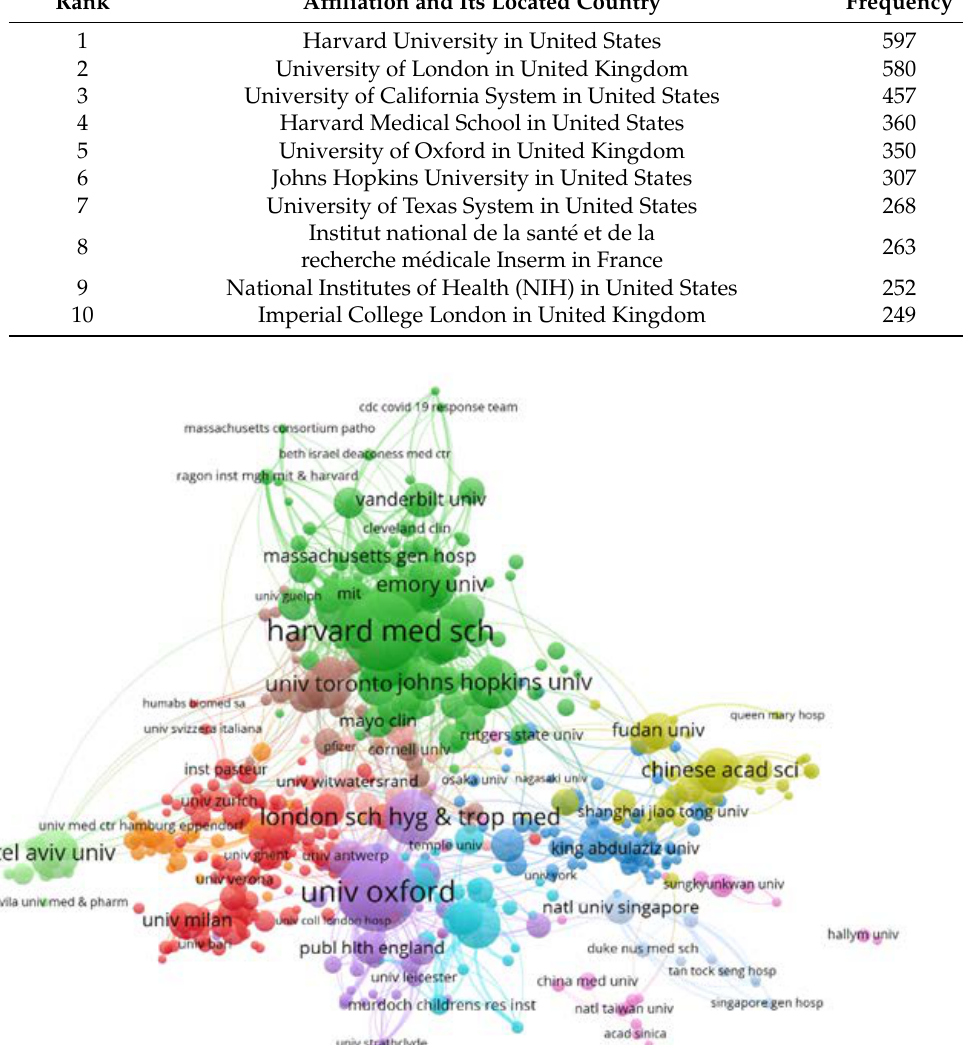
Table 2. The top 10 affiliations of publications on COVID-19 vaccines. Rank Affiliation and Its Located Country